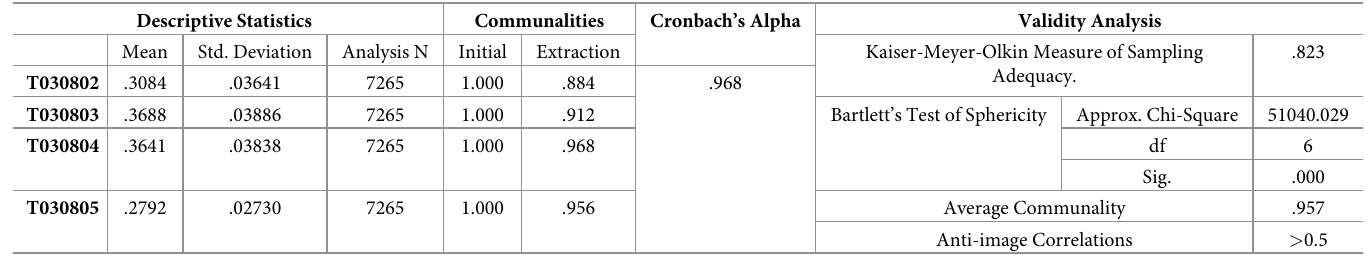
Table 4. Reliability and validity analysis of gas data in Case Study